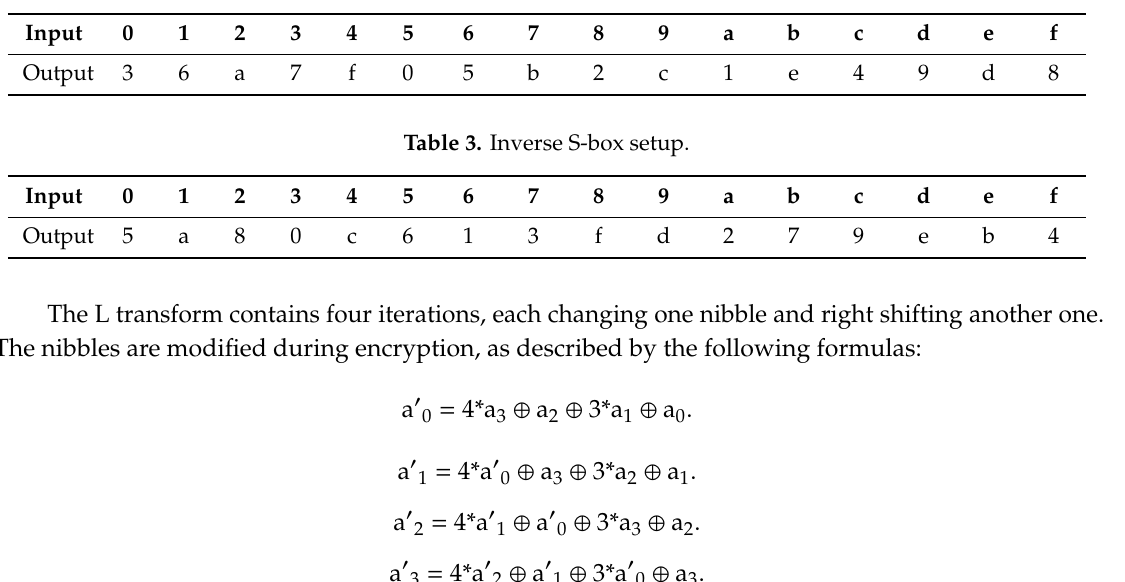
Table 2. S-box setup.